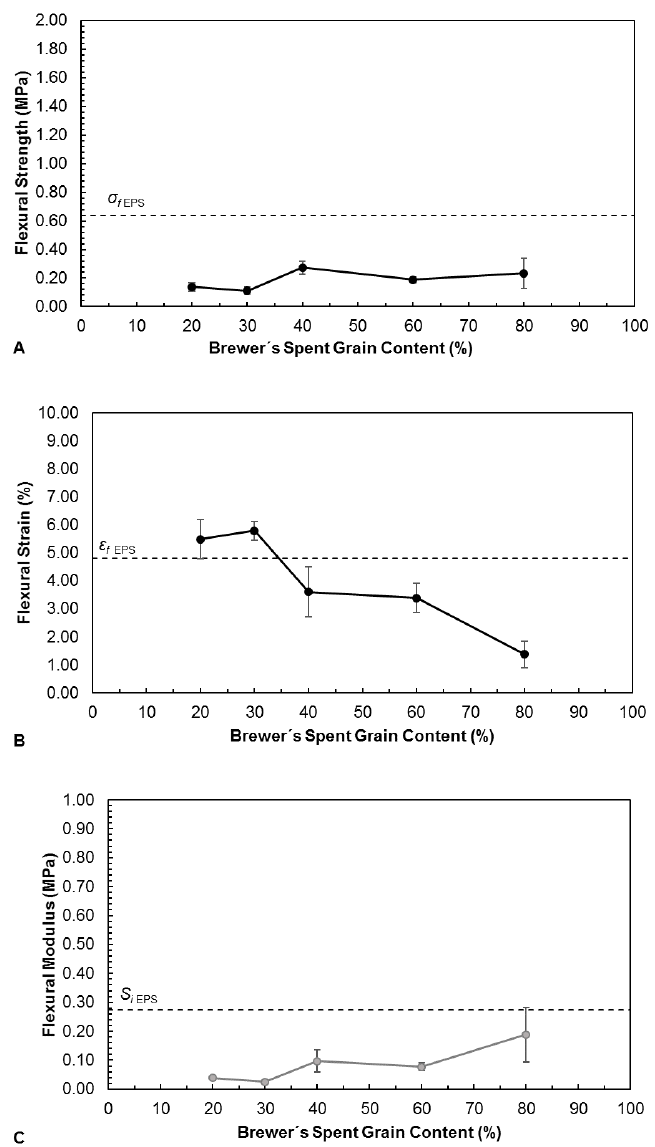
Figure 6. Flexural strength ( A ), Flexural strain ( B ) and Flexural modulus ( C ) at break of trays produced with different contents of Brewer´s Spent Grain, after water absorption. The horizontal dashed line represents the flexural strength of EPS trays.